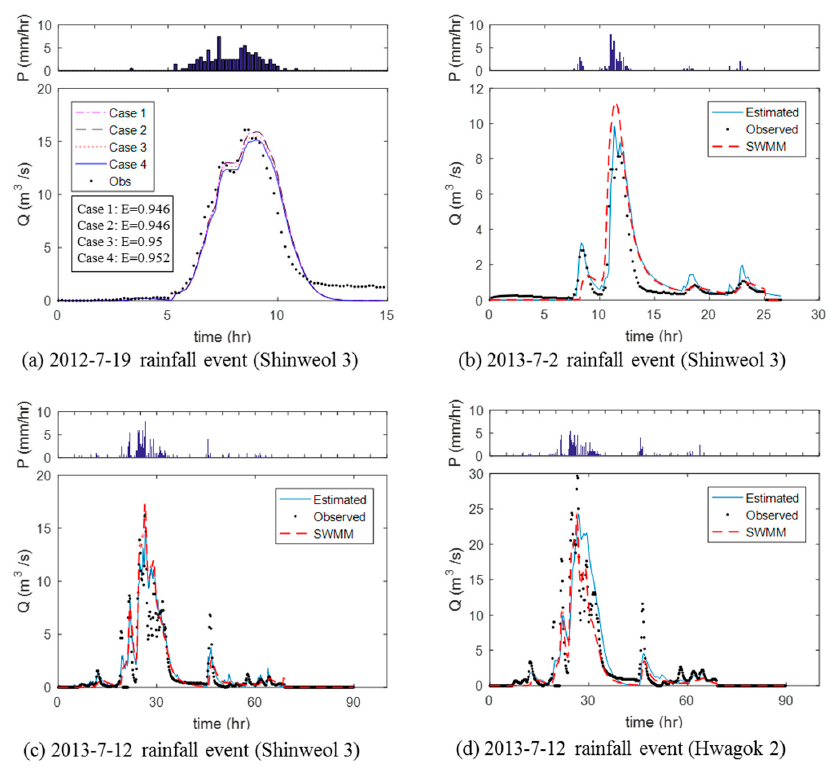
Figure 6. Runoff hydrographs estimated by WFIUH compared with observation and detailed SWMM.